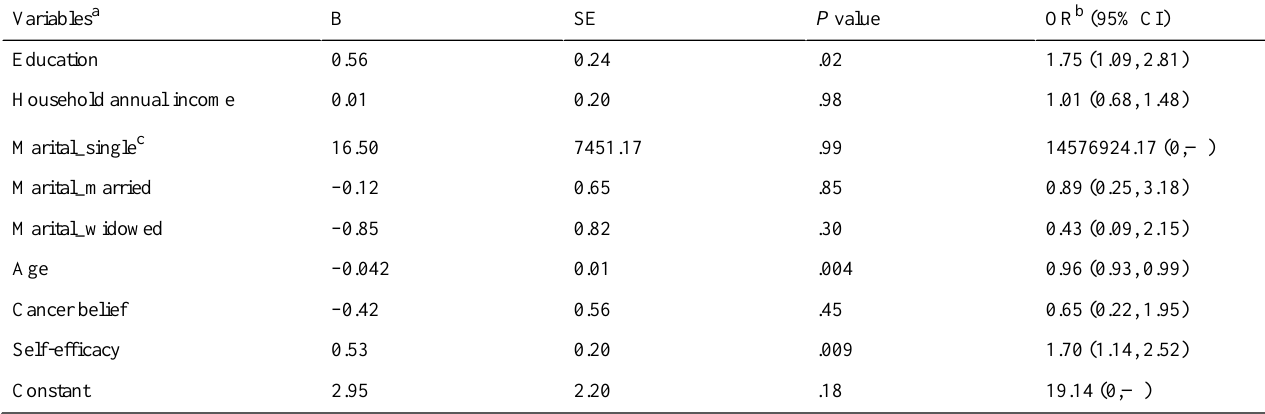
Table 4. Results of logistic